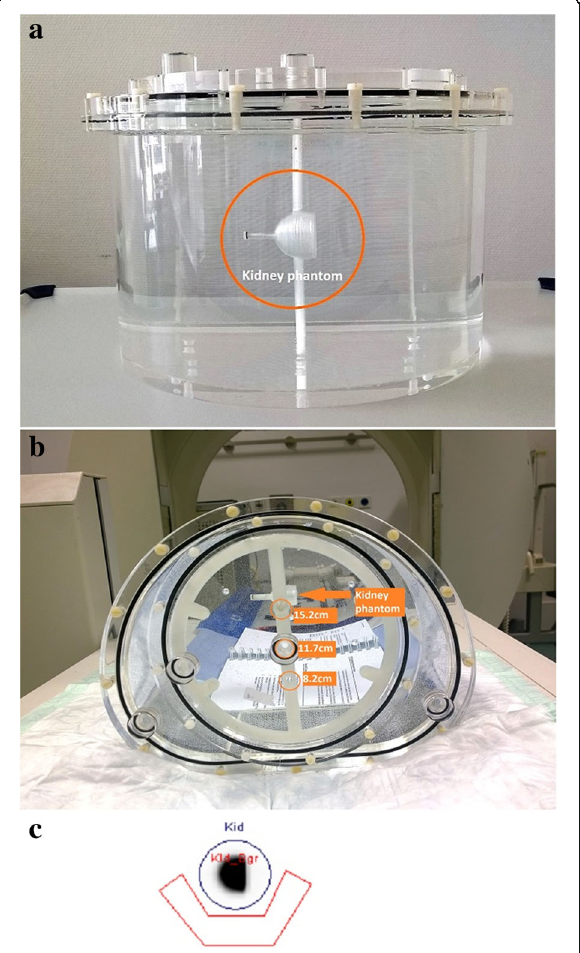
Fig. 2 Phantom experiment. a Kidney insert (newborn) mounted on the torso-phantom. b Kidney insert mounted on the torso-phantom using the manufactured attachment system with three different depth positions: 8.2 cm, 11.7 cm, and 15.2 cm. c Exemplary ROI positioning for the phantom ( dark blue ) and the background ( red